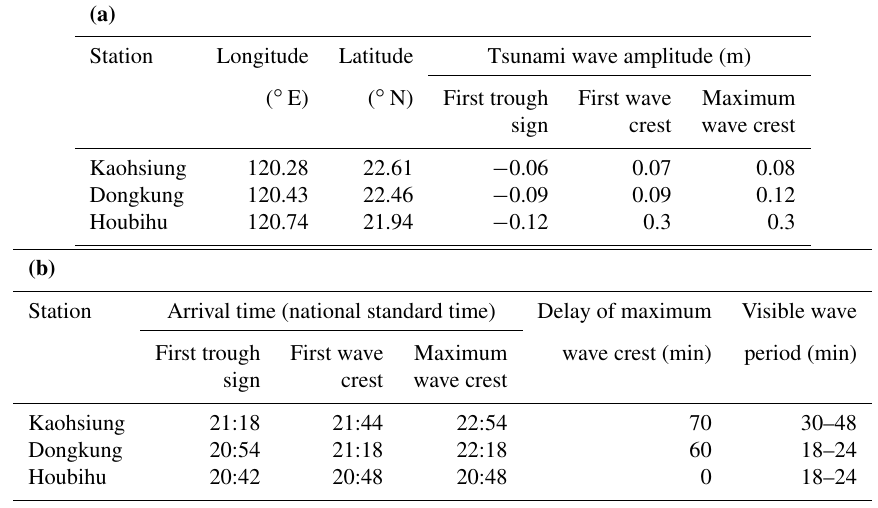
Table 6. (a) Details of the tide gauge stations and physical characteristics of tsunami waveforms during the 2006 tsunami. (b) Details of the tide gauge stations and physical characteristics of tsunami waveforms during the 2006 tsunami.